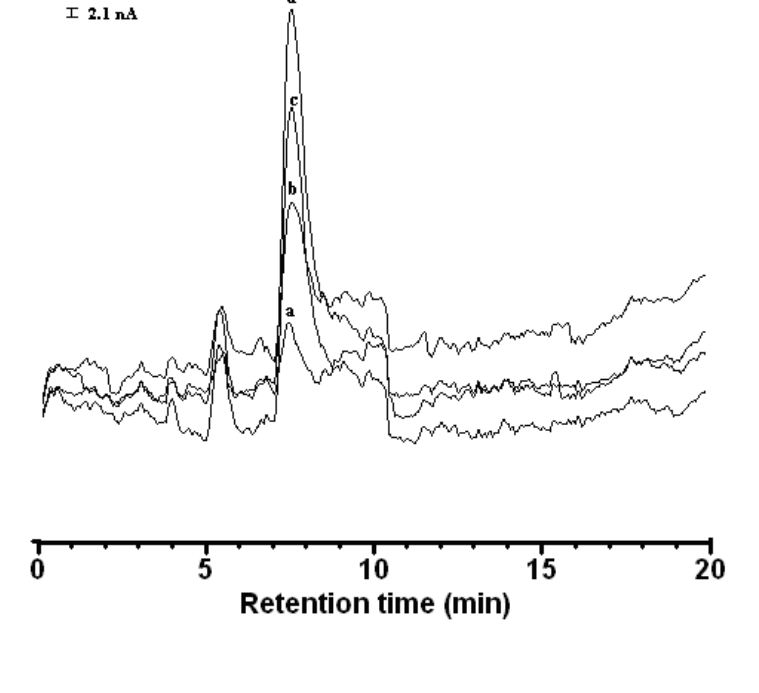
Figure 14. The LC-ECD chromatograms recorded to produce analytical curves for cysteine. Peaks; ( a ) 1.0 mg·L − 1 ; ( b ) 2.0 mg·L − 1 ; ( c ) 3.0 mg·L − 1 ; ( d ) 4.0 mg·L − 1 . Liquid chromatography